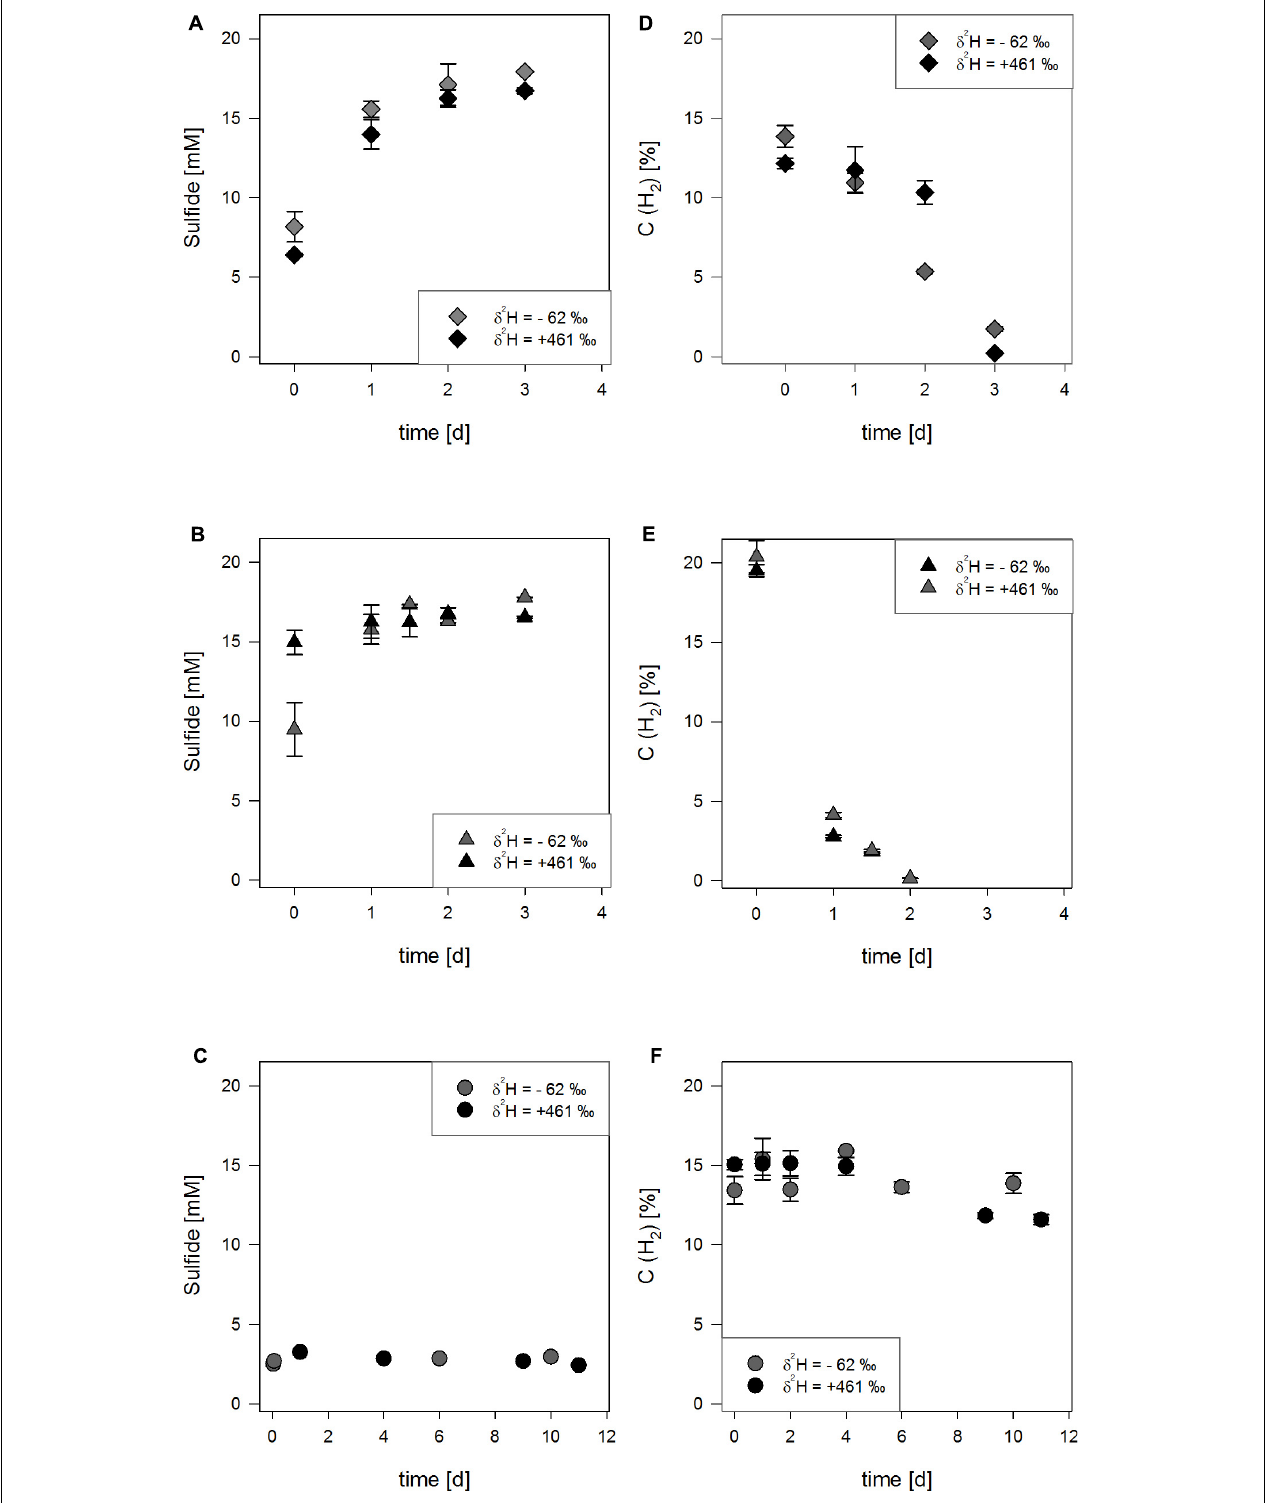
FIGURE 2 | Concentration of H 2 (empty symbols) and sulfides (filled symbols) for three experimental setups (A,D) : (cid:7) setups with reduced sulfide burden, (B,E) : (cid:78) setups without further treatment, (C,F) : is